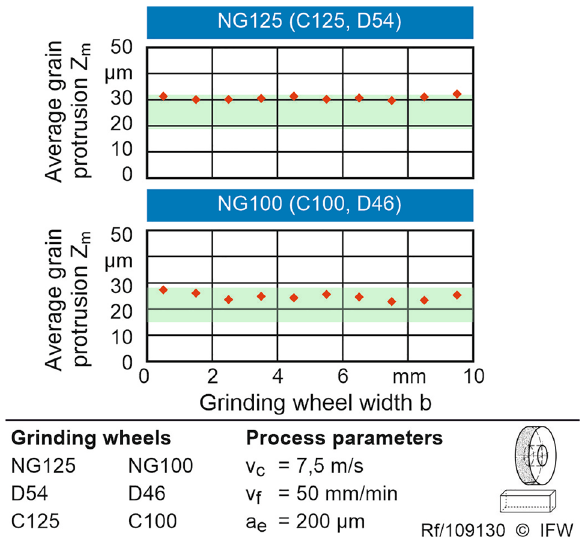
Fig. 8 Course of average grain protrusion for non-graded grinding wheels